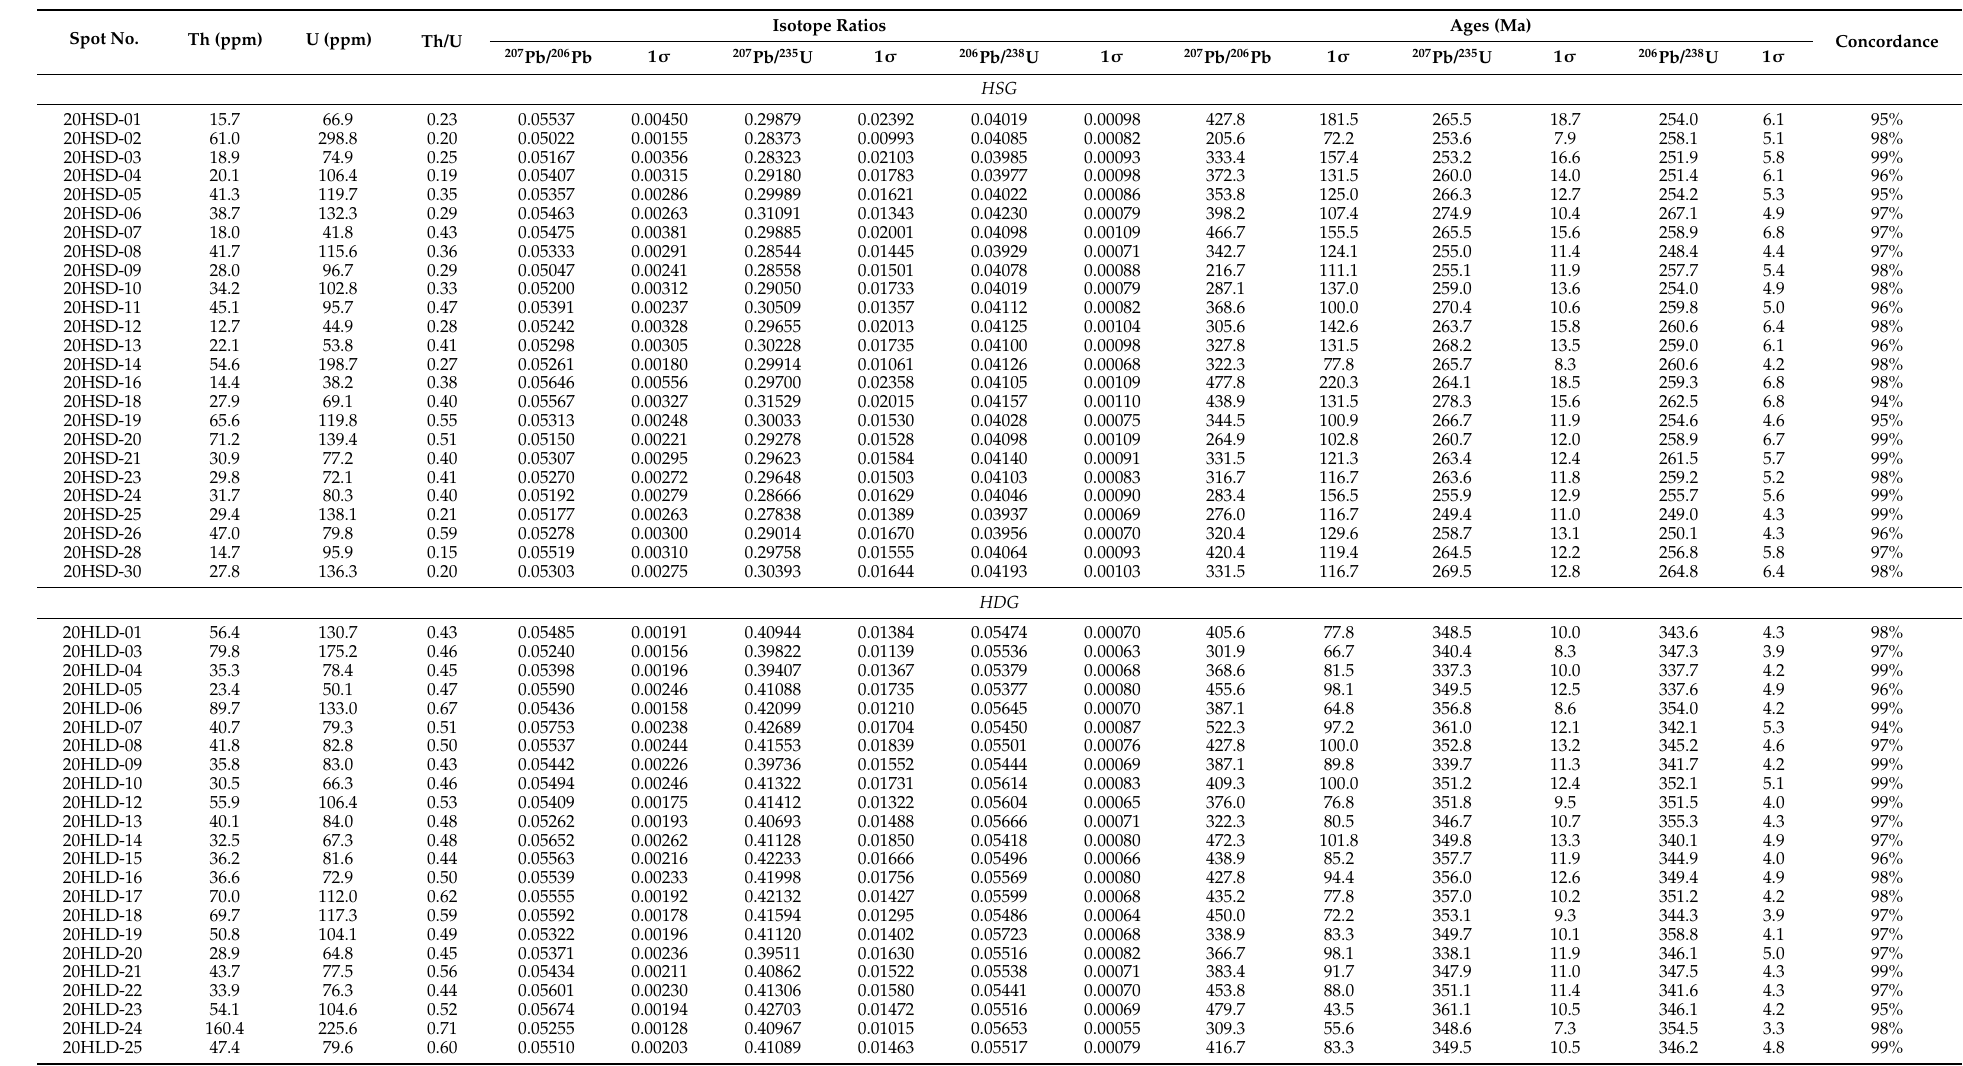
Table 1. LA-ICP-MS U-Pb data of zircon grains from HSG and HDG of the